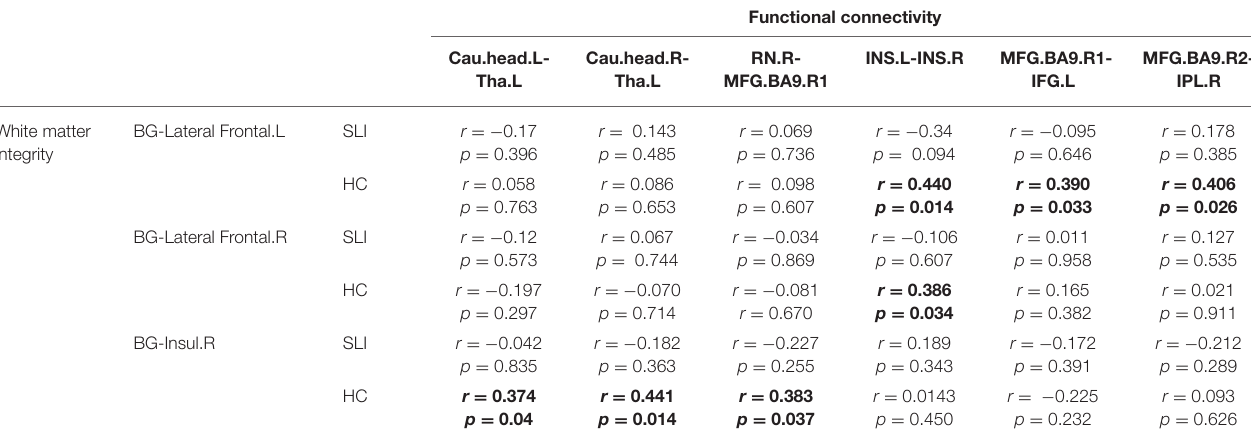
TABLE 2 | Structural and functional BG-cortical connectivity